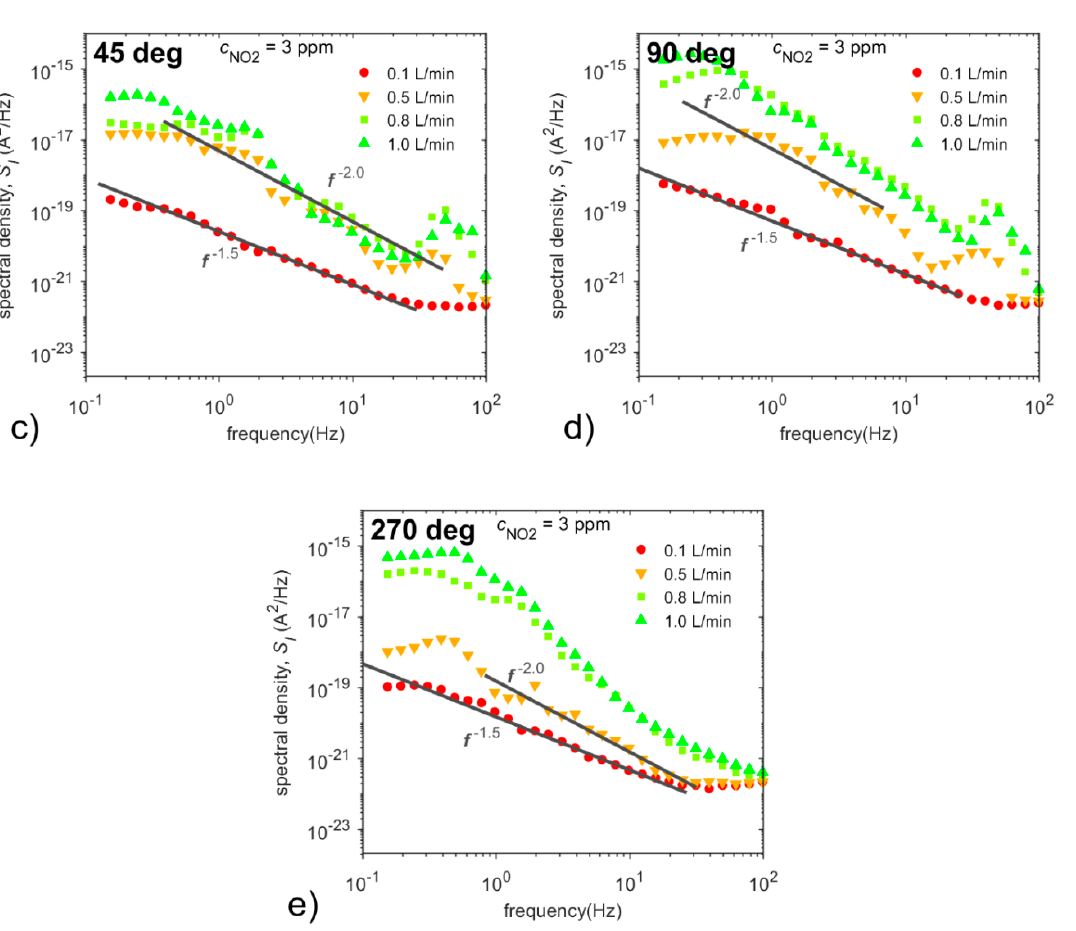
Figure 15. Spectral densities of current fluctuations depending on flow rates at NO 2 concentrations of 3 ppm for the frequency range from 0.1 Hz up to 100 Hz for the sensor located: ( a ) at the bottom of the gas chamber, and for the sensor located in the middle of the gas chamber at the angles ( b ) 0 ◦ , ( c ) 45 ◦ , ( d ) 90 ◦ and ( e ) 270 ◦ . Conditions: 298 K, 40 %RH.